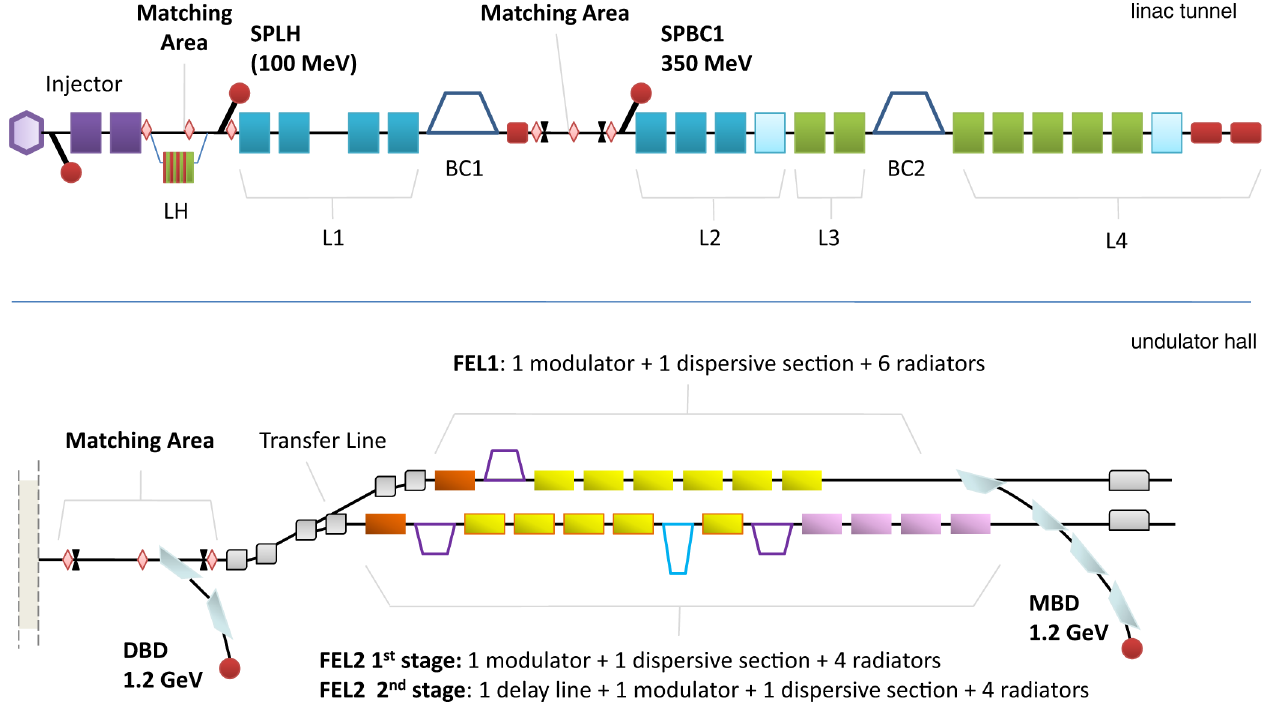
FIG. 1. Split layout of the FERMI FEL (conceptual, not to scale). The linac includes the injector, the laser heater (LH) area, different types of accelerating structures—represented with different colors—accommodated in linac 1 (L1), linac 2 (L2), linac 3 (L3), and linac 4 (L4), two magnetic chicanes for bunch length compression (BC1 and BC2), three optics matching area, the laser heater spectrometer line (SPLH), the first compressor spectrometer line (SPBC1), and the diagnostic beam dump (DBD). A transfer line brings the electron beam to the FEL1 or FEL2 undulator line (different undulator segments are represented by different colors), followed by the main beam dump (MBD)